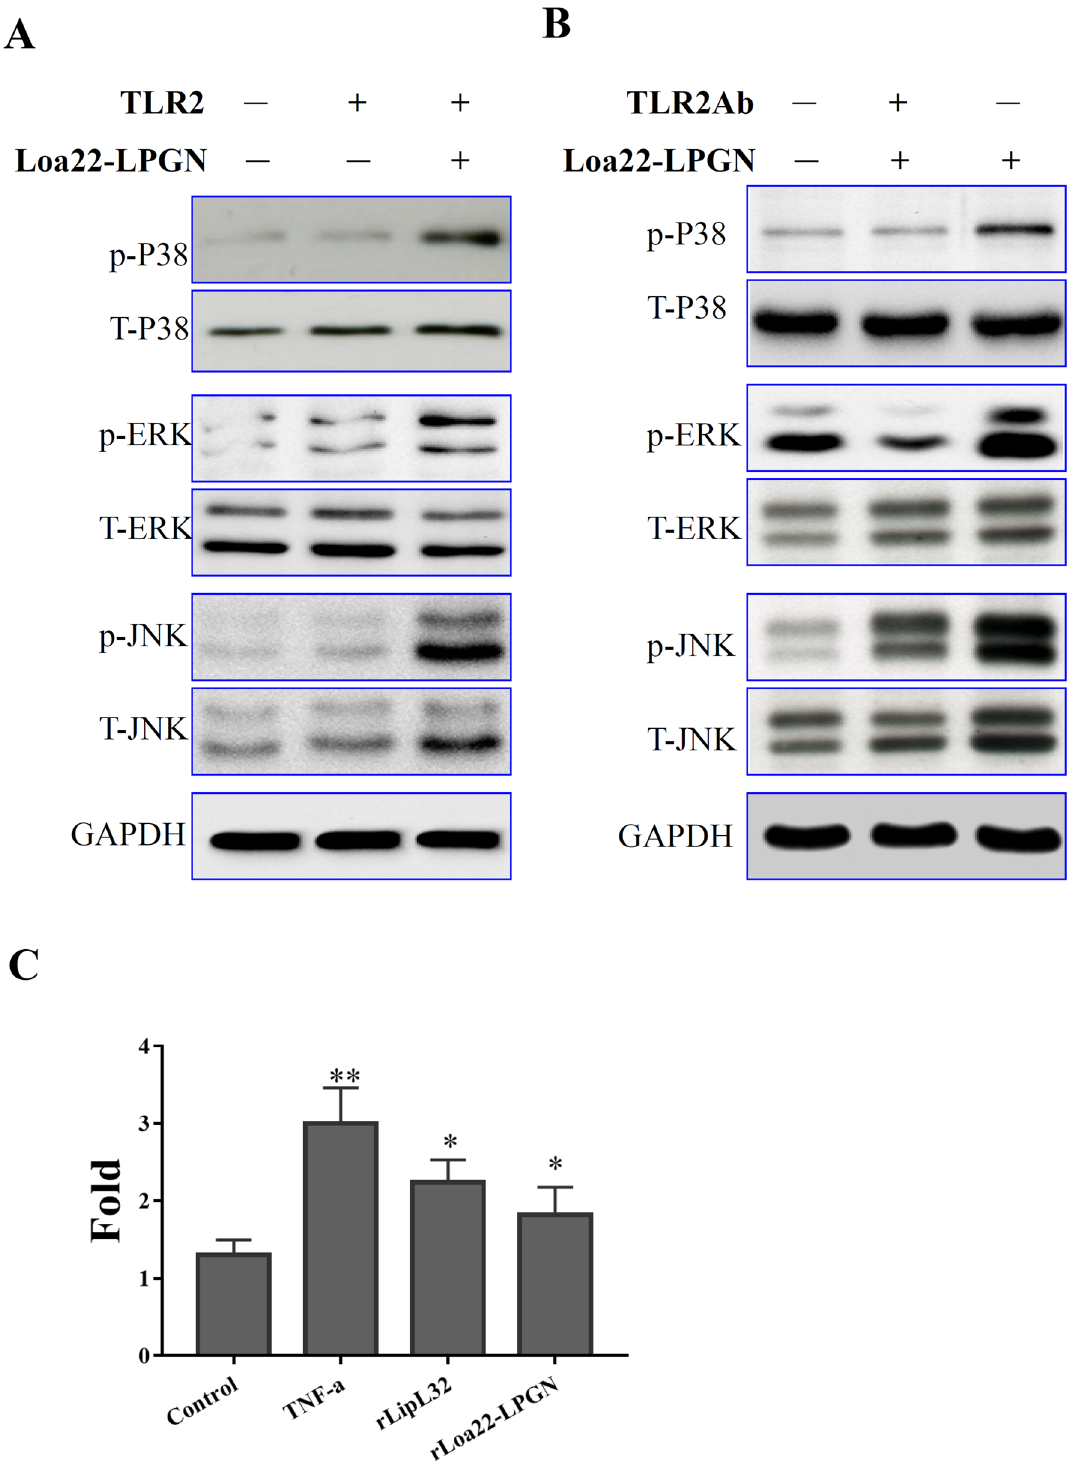
Figure 5. TLR2 downstream signaling cascades assays after rLoa22-LPGN complexes stimulation. HEK293-TLR2 cells were cultured to 70% confluence and serum free for 16 h before adding the stimulation agents (0.1 μg/ml). The cells were incubated with the stimulation agents for 1 h and collected for western blot analysis. ( A ) rLoa22-LPGN complexes stimulated HEK293 and HEK293-TLR2 cells for 1 h and downstream signaling cascades were assayed. ( B ) rLoa22-LPGN complexes stimulated HK2 cells in the presence and absence of TLR2 antibody and downstream signaling cascades were assayed. Anti-TLR2 antibody (1 μg/ml) was used to pretreated HK2 cell for 1 h before adding the rLoa22-LPGN complexes. ( C ) Luciferase assay of NF-κB in HEK293 cell. HEK293-TLR2 cell transfected with pNF-κB luc plasmid and NF-κB translocation activity was assayed by luciferase reporter assay. PBS was used as control and TNF-α was used as positive control. rLipL32 and rLoa22-LPGN were used to stimulate TLR2 downstream signaling cascades and promoted NF-κB translocated into nuclus. ⃰ p < 0.05; ⃰ ⃰ p <